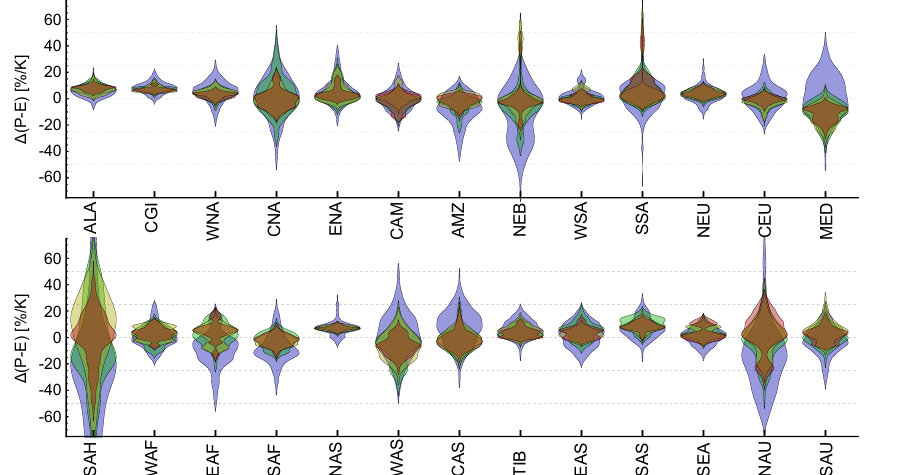
Figure 8. Uncertainty distributions (shown as violin plots) of the sensitivity of P − E to global mean temperature change for each emission scenario averaged over all SREX regions (as outlined in Table 2 and Fig. 4). It is important to note that the data considered to estimate the area average are scarce in some regions (e.g. SAH). Please also refer to Fig. 7 for more